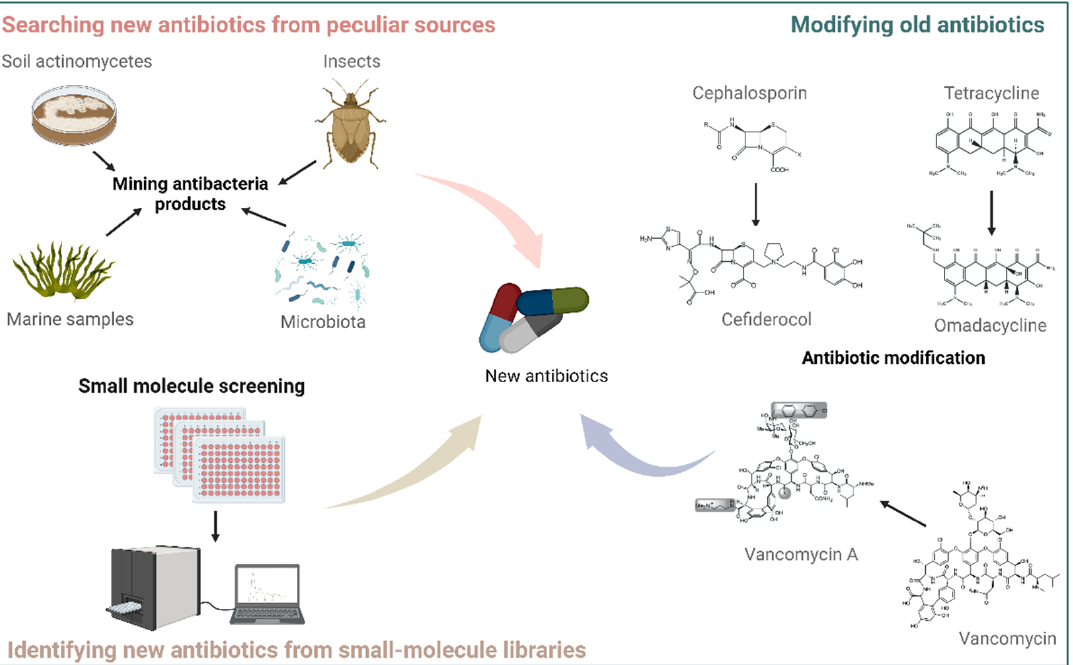
Figure 2. New antibiotics are mined by the following three strategies: modification of old antibiotics, screening of small ‐ molecule libraries, and exploration of peculiar places.